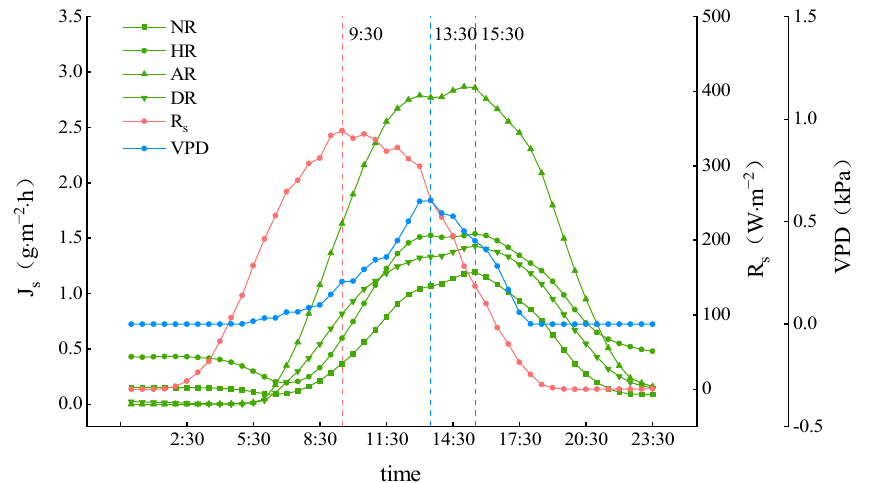
Figure 5. Relative relationships of the peak time lag between sap flow (J S )and meteorological variables during typical sunny days. The sap flow (J S ) of four treatments area are NR treatment (NR), HR treatment (HR), AR treatment (AR), and DR treatment (DR). The meteorological variables are solar radiation (R S ), and vapor pressure deficit (VPD).